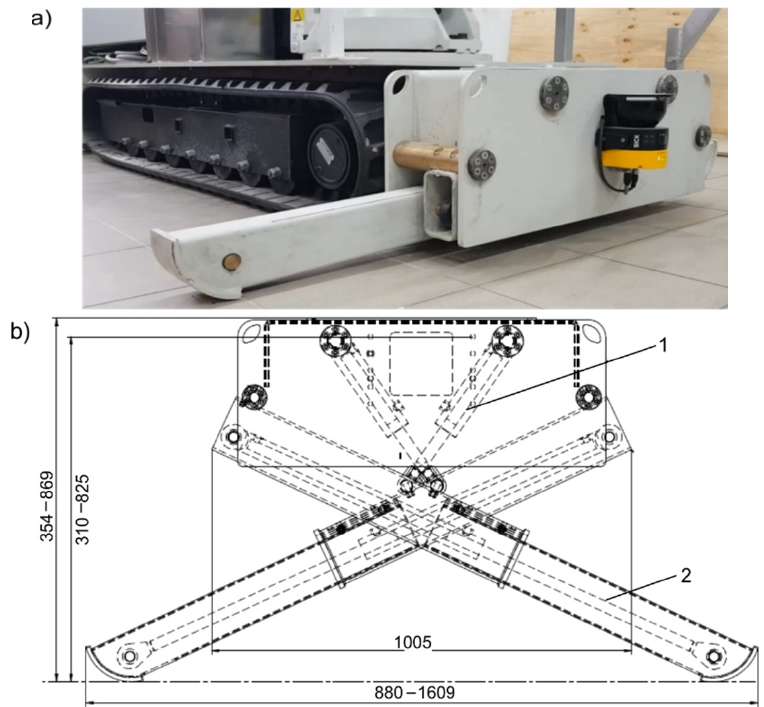
Figure 3. HLL module: ( a ) view of the extendable supporting leg, ( b ) technical drawing of the cross system of the hydraulic lifting actuators, 1: hydraulic lifting actuator, 2: supporting leg.